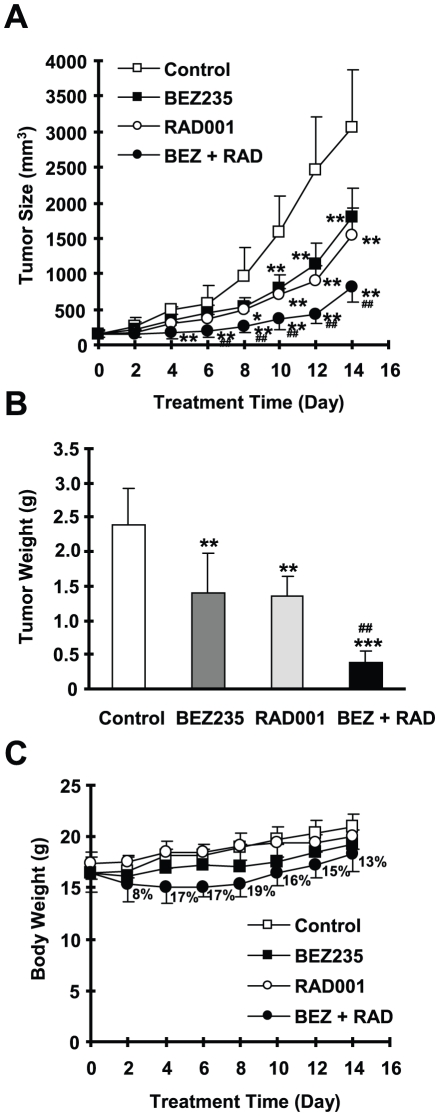
The combination of BEZ235 and RAD001 is significantly more effective than each single agent in suppressing the growth of NSCLC xenografts.A549 xenografts were treated (once a day) with vehicle control, RAD001 (3 mg/kg, og), BEZ235 (20 mg/kg, og) and their combination (BEZ+RAD) starting on the same day after grouping. Tumor sizes (A) and body weight (C) were measured once every two days. After 14 days, the mice were sacrificed and the tumors were removed and weighed (B). Each measurement is a mean ± SD (n = 6). The numbers in C represent body weight loss in the combination group compared with control group. * P<0.05 compared with vehicle control; ** P<0.01 compared with vehicle control; *** P<0.001 compared with vehicle control; ##
P<0.01 compared with RAD001 or with BEZ235.